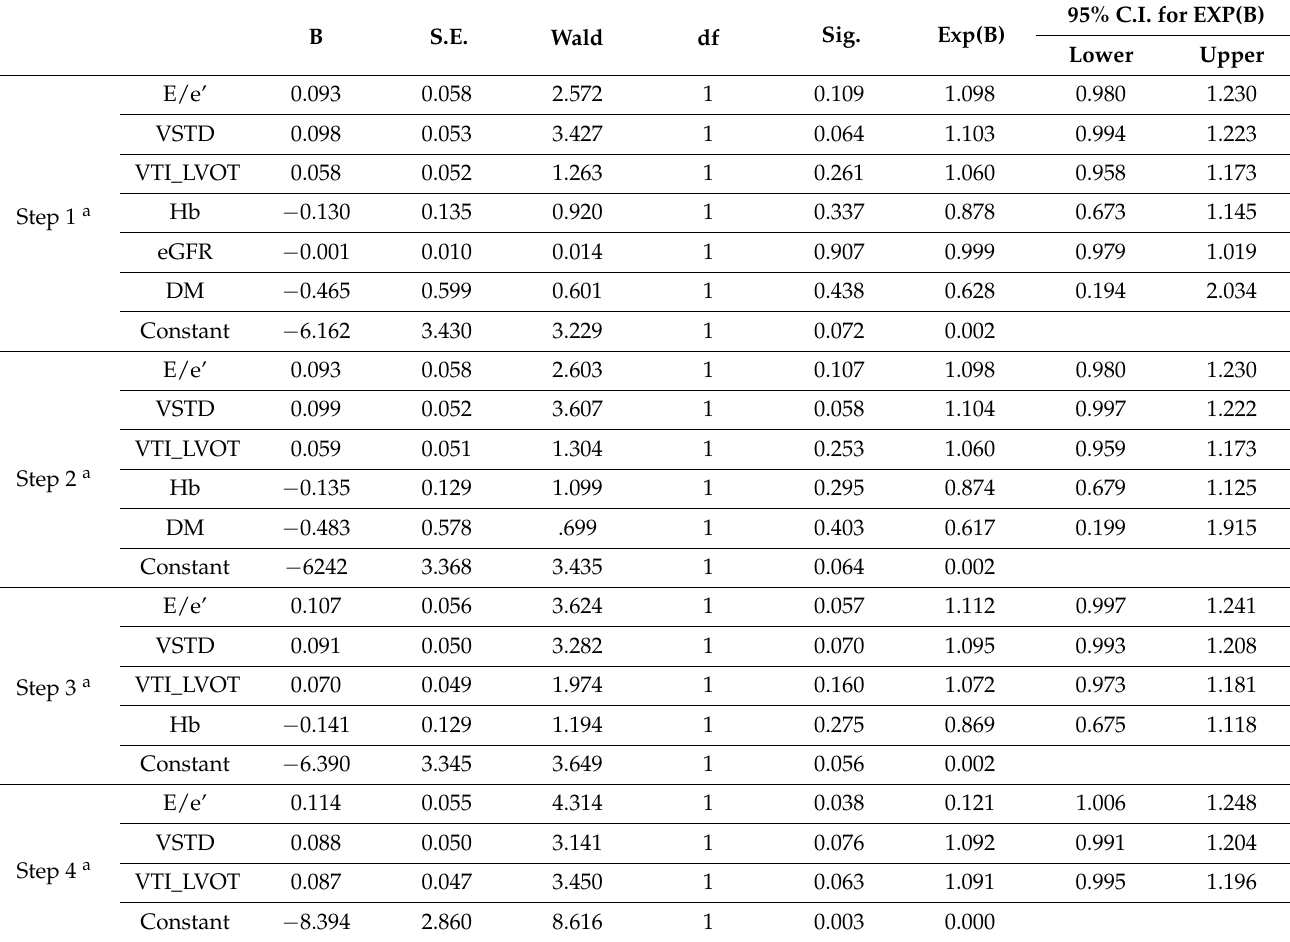
Table A2. Variables in the Equation of the model, backward approach.